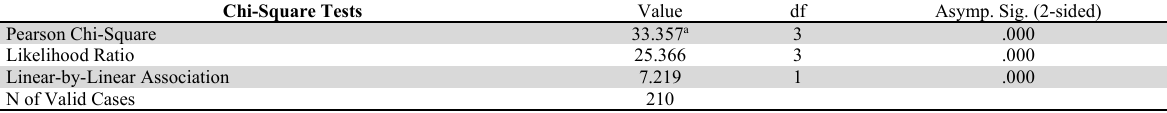
Chi-Square Tests on Development of Household Economic Resources